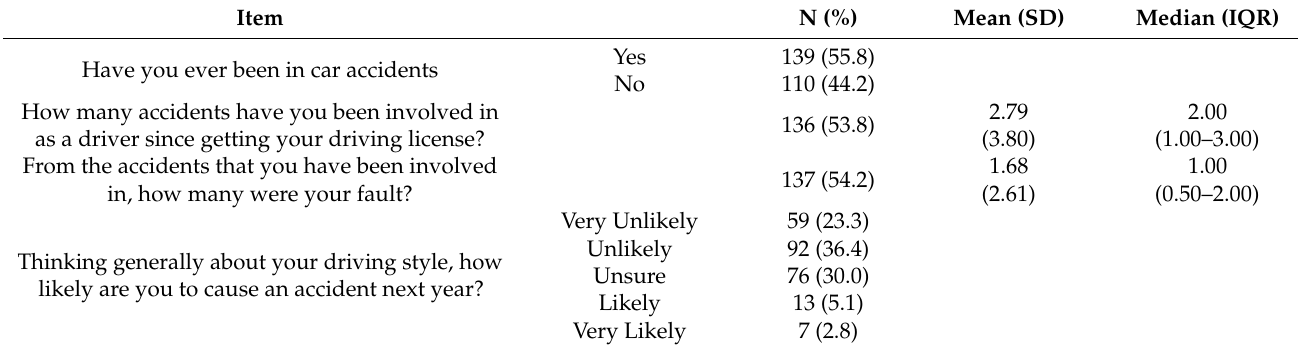
Table 3. Young drivers’ experience with crash